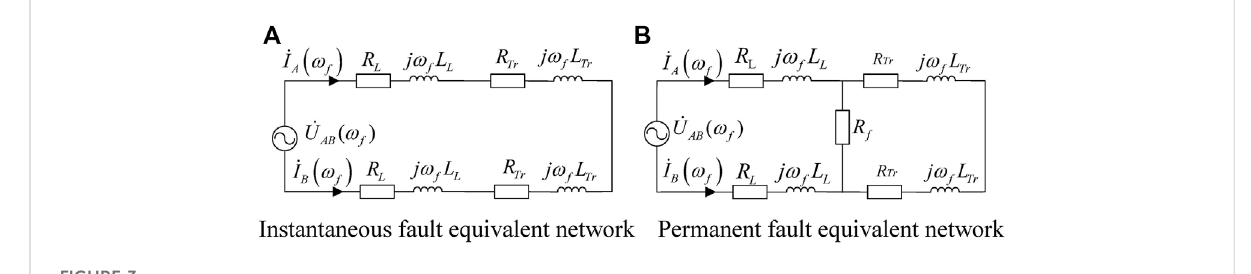
FIGURE 3 Equivalent network for inter phase short circuit fault